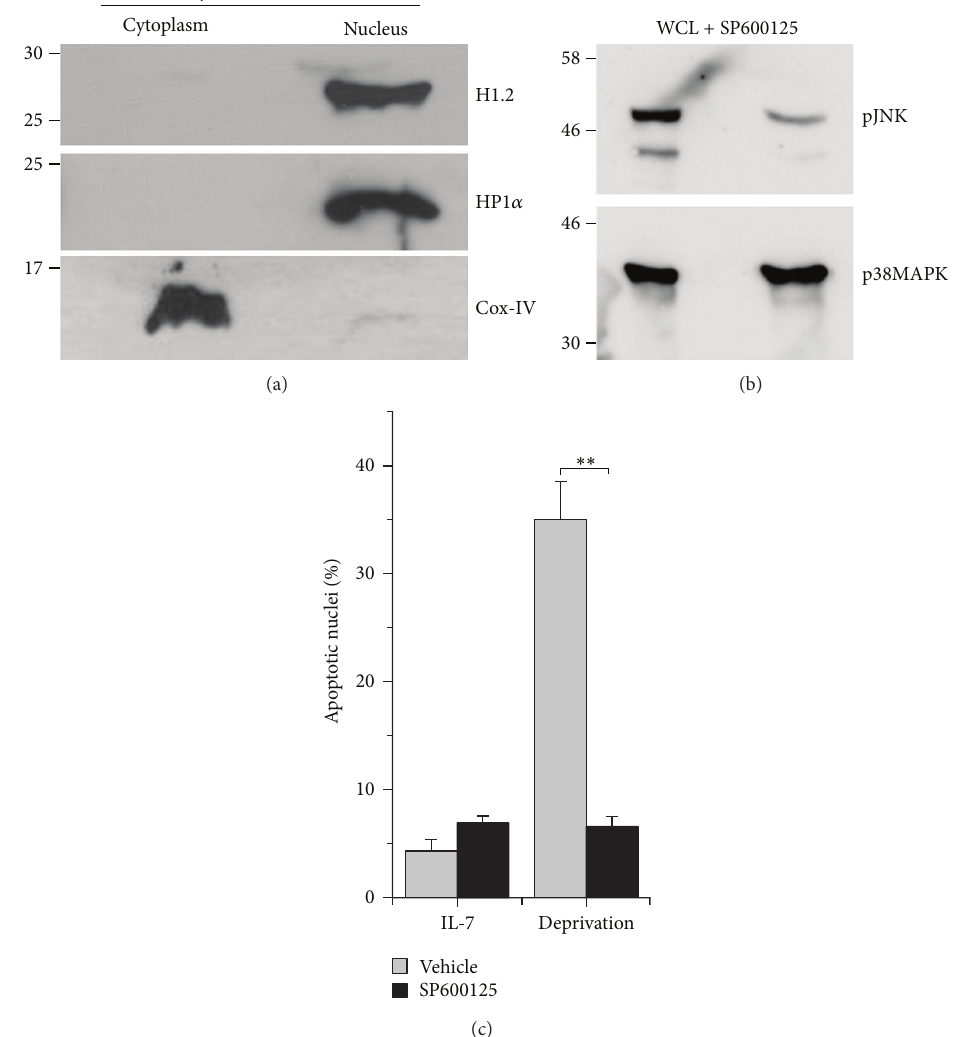
Figure 4: JNK regulates H1.2 displacement in T-effectors. (a) Representative immunoblot of nuclear and cytoplasmic fractions of T-effectors cultured without cytokine +100nM SP600125 for 6 hours. The immunoblots were probed with antibodies to H1.2, HP1 𝛼 , and Cox-IV and controlled with fractions generated in previous experiments. Data shown is representative of two independent trials. (b) Representative immunoblot for phosphorylated JNK in T-effectors cultured as described in (a). p38MAPK is the loading control. (c) Apoptotic nuclear damage in T-effectors cultured with and without cytokine (IL-7) in the presence or absence of vehicle control or 100nM SP600125 for 24 hours. The graph shows the mean ± SD from 3 experiments. ∗∗ 𝑃 < 0.001